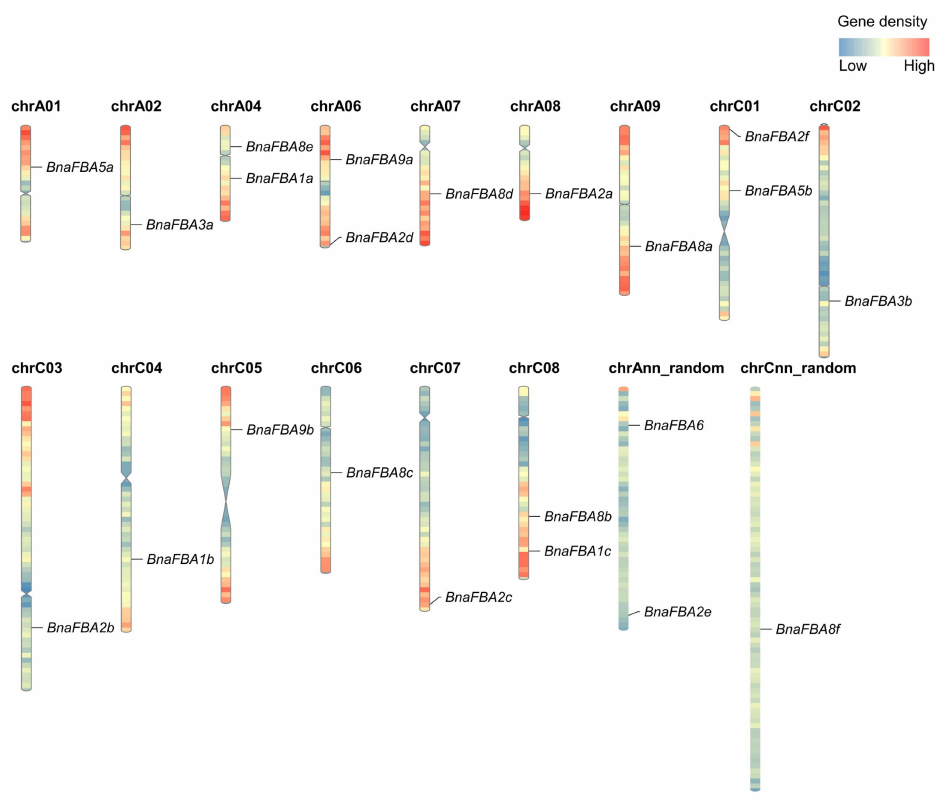
Figure 1. Genomic distributions of BnaFBA genes on B. napus chromosomes. The BnaFBAs were plotted based on the location of genes, length of chromosomes, and positions of centromeres. Heatmap of each chromosome indicated the gene density by the frequency per 1